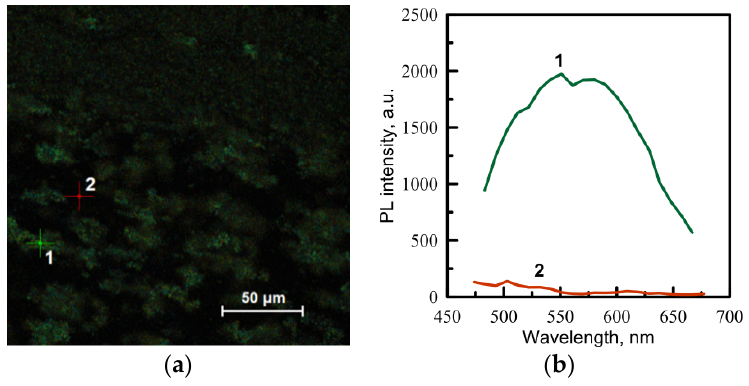
Figure 6. ( a ) Fluorescence images of the irradiated area of a 1% Cd(C 12 H 25 S) 2 /PMMA sample. ( b ) PL spectra from two different points, 1 and 2, of the region exposed to laser